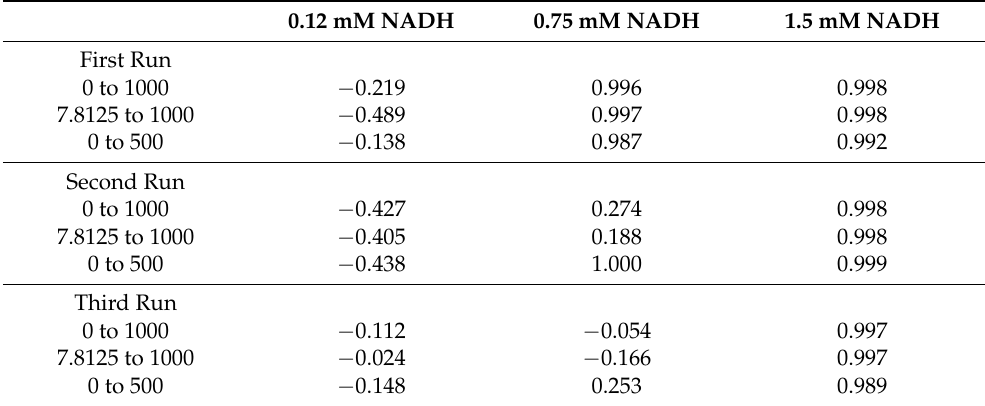
Table 1. Correlation coefficients between ALT [U/L] and maximum reaction velocity [milliunits/min] depend on NADH concentration in ALT